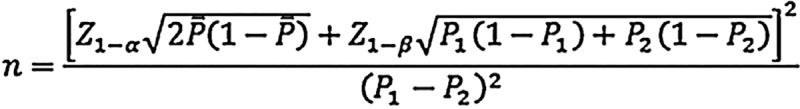
Sample size formula.